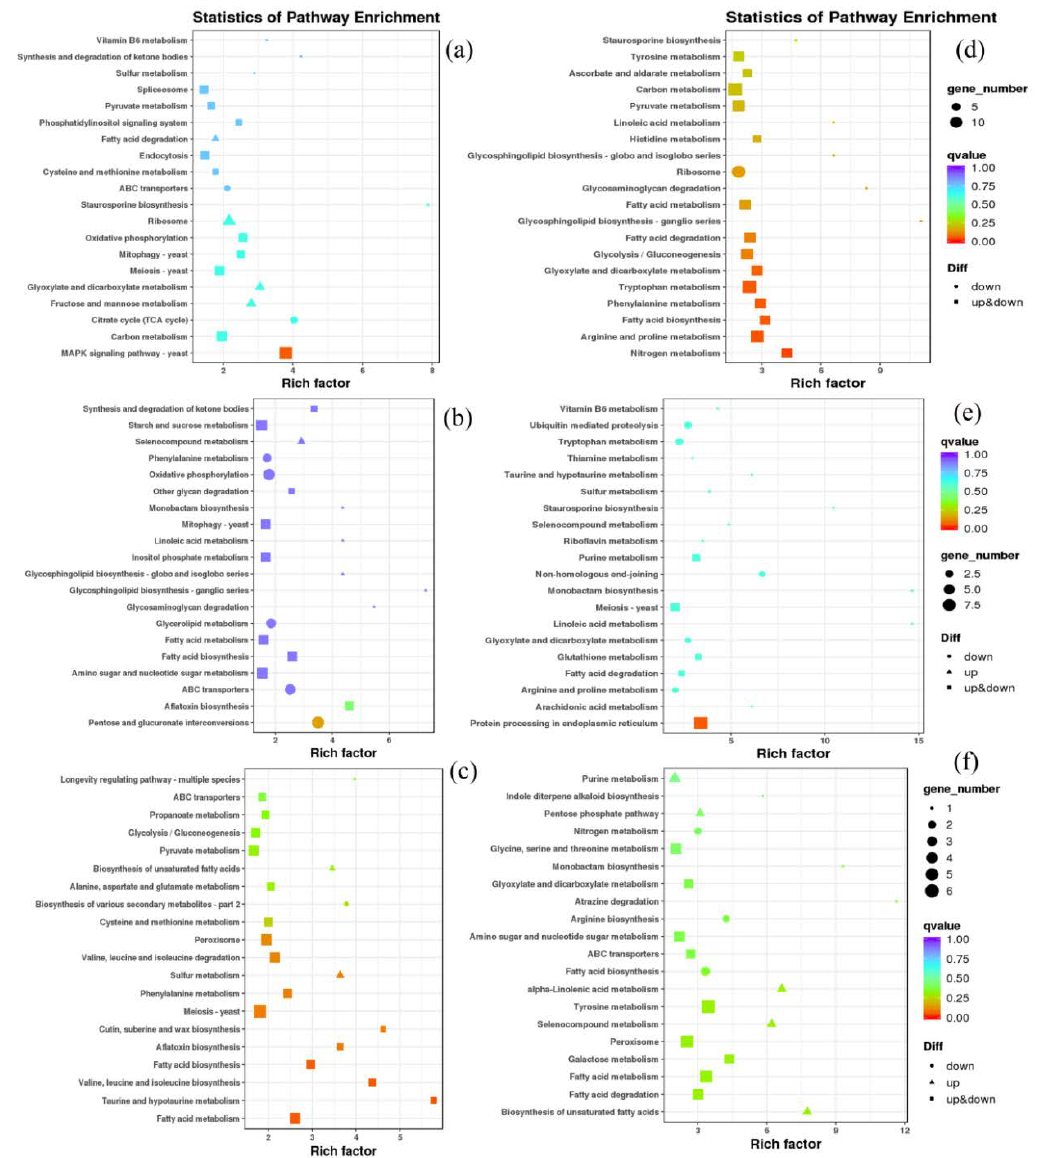
Figure 7. Plot of KEGG pathway enrichment of six Cenococcum geophilum isolates up-regulated differentially expressed genes. ( a ) ACg07 (25 °C vs. 30 °C), ( b ) ChCg28 (25 °C vs. 30 °C), ( c ) ChCg100 (25 °C vs. 30 °C), ( d ) ChCg01 (25 °C vs. 30 °C), ( e ) JaCg144 (25 °C vs. 30 °C), ( f ) JaCg202 (25 °C vs. 30 °C).